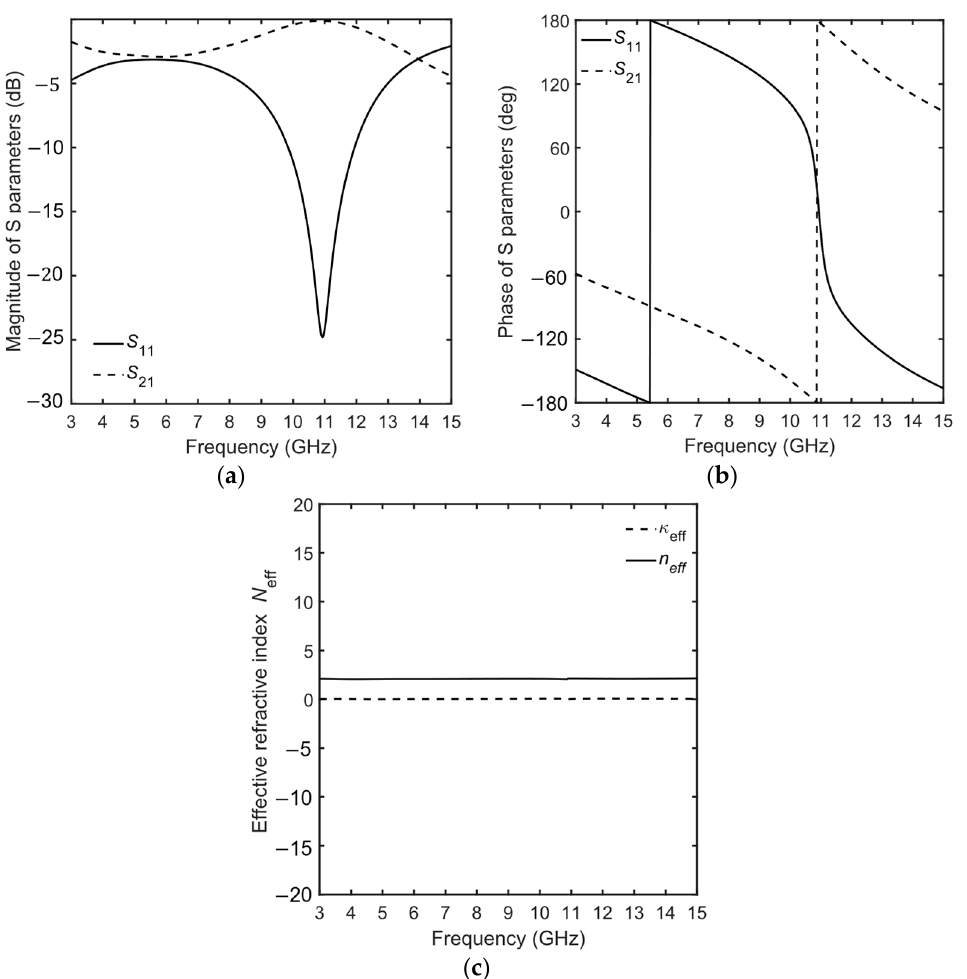
Figure 7. ( a ) Magnitude and ( b ) phase of the simulated S-parameters and retrieved effective parameters of L-shaped unit cell as a function of frequency. ( c ) Refractive index N ef f